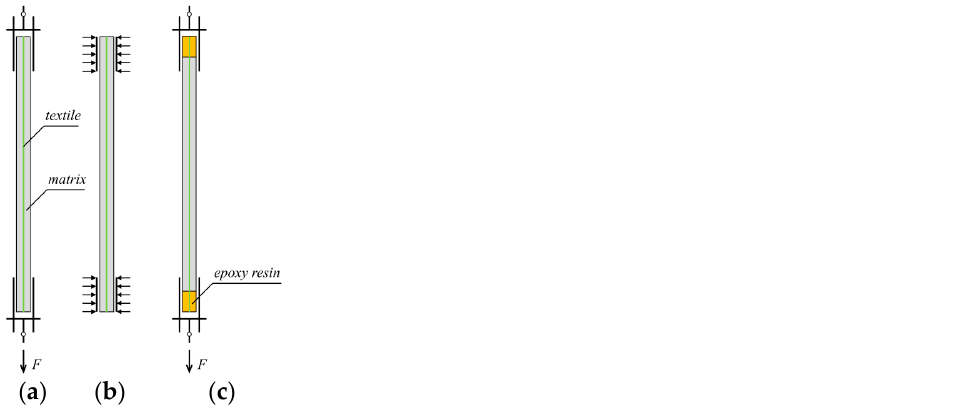
Figure 1. Tensile test setups: ( a ) clevis-grip; ( b ) clamping-grip; and ( c ) improved clevis-grip (proposed by the authors).